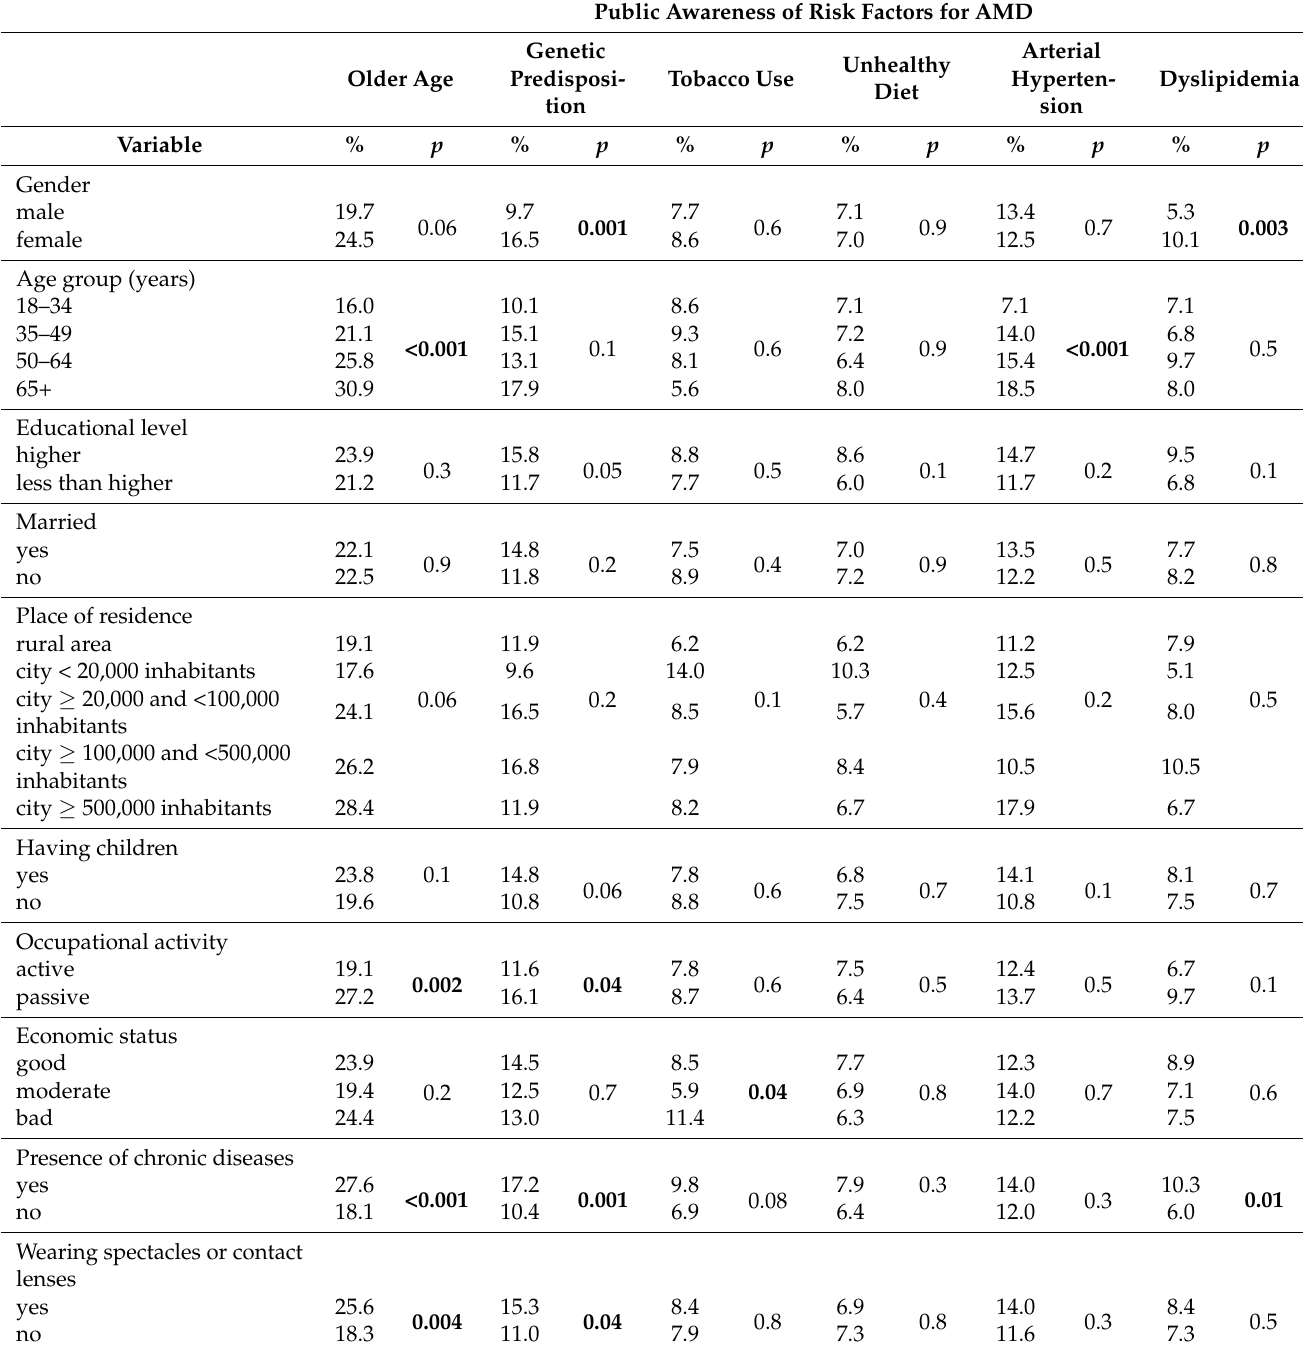
Table 5. Public awareness of risk factors for AMD by sociodemographic factors (n = 1076). Public Awareness of Risk Factors for AMD Genetic Unhealthy Older Age Predisposi- Tobacco Use tion